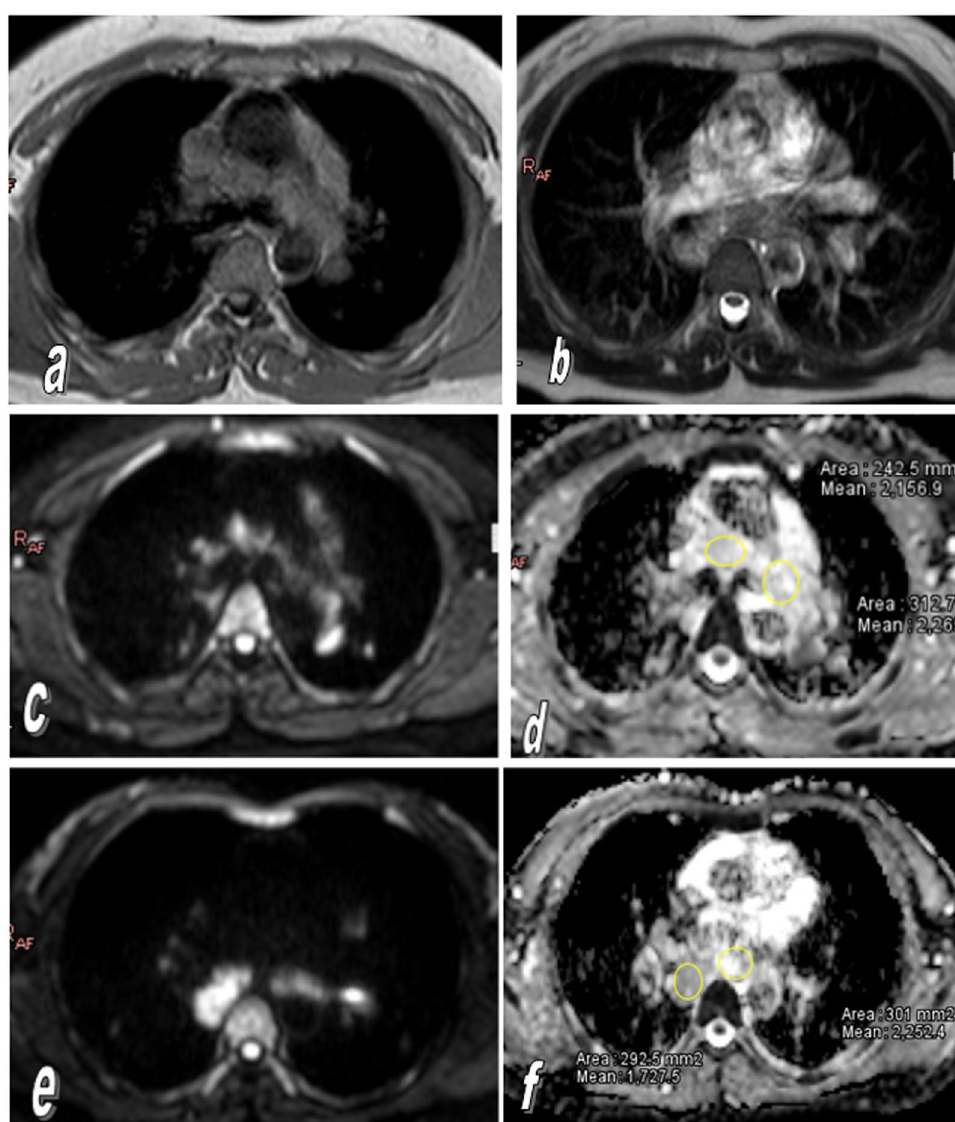
Fig. 2 a Axial T1WI, b axial T2WI, c , e diffusion-weighted MRI image, d , f ADC map showing exuberant partially amalgamated mediastinal lymphadenopathy seen predominantly involving the paratracheal, bilateral hilar and subcarinal lymph node groups as well as prevascular, retrosternal and retrocaval lymph node groups. They display intermediate T1 WI, intermediate to hyperintense T2 WI, hyperintense on DWI and mixed signal on ADC map with mean ADC value of 2.1 10 − 3 mm 2 ×